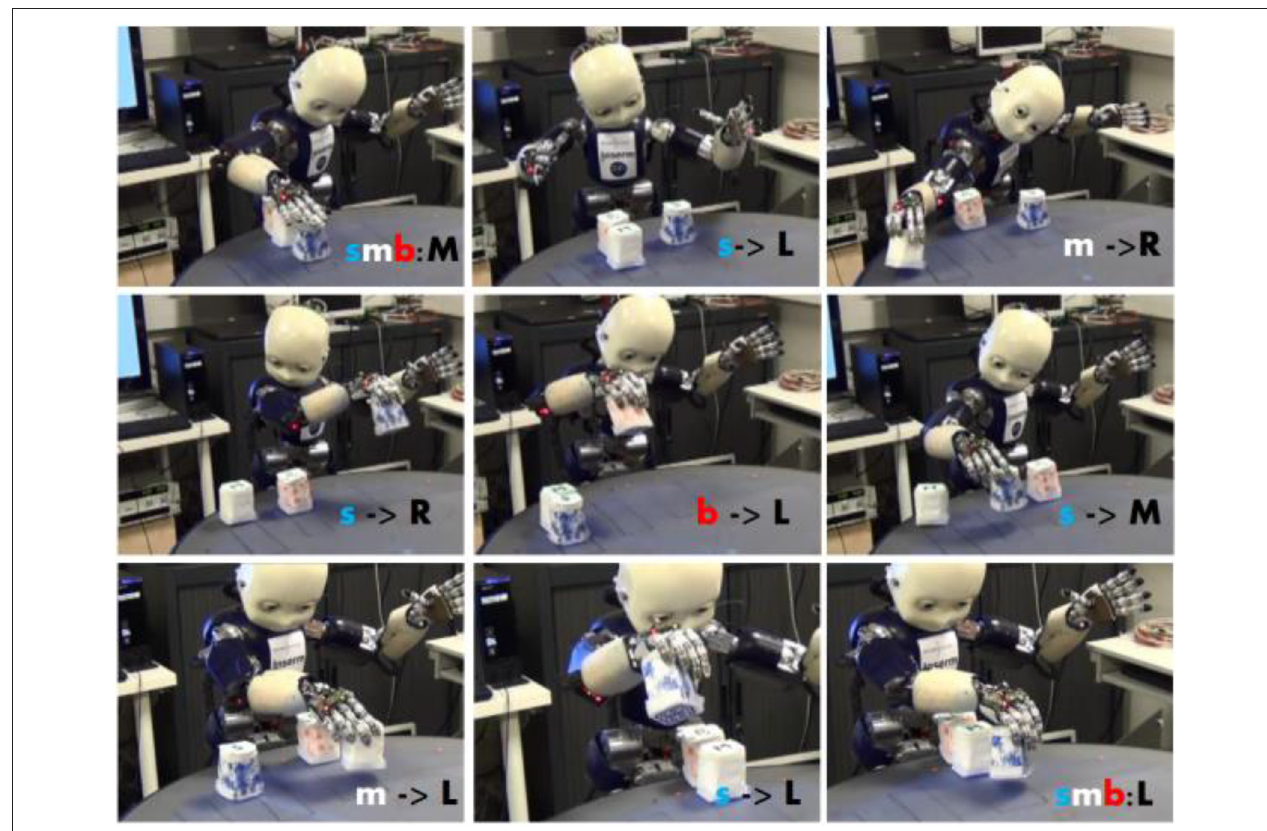
FIGURE 9 | iCub solves a “Table of Hanoi” task, moving the small, medium and big object, from the Middle location to the Left location, after learning the rules that a larger object cannot go to a location where there is already a smaller object. These rules are used in a standard planner to allow the system to solve new instances of the task small-s, medium-m, big-b, middle-M, left-L, right-R. Intially all objects are at M, and the goal is to move them to L. From Petit et al. (2016).